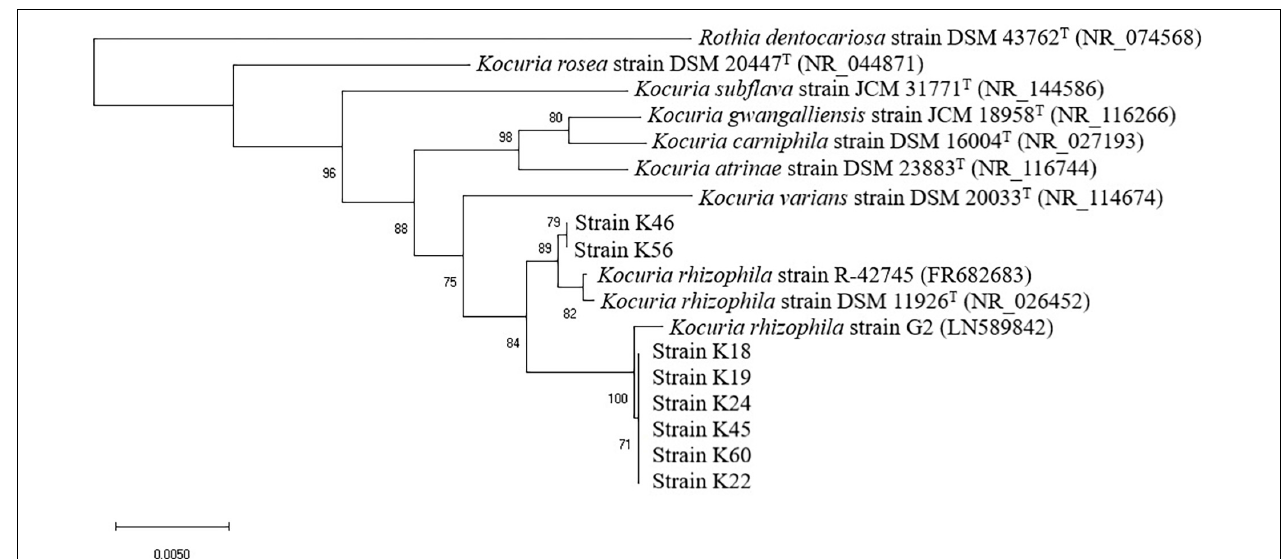
FIGURE 1 | Neighbor-joining phylogenetic tree of eight isolates from Nuodeng hams and reference strains of the genus Kocuria constructed using their 16S rRNA gene sequences. The numbers at the nodes are bootstrap probabilities in percent. The scale bar indicates the number of substitutions per nucleotide